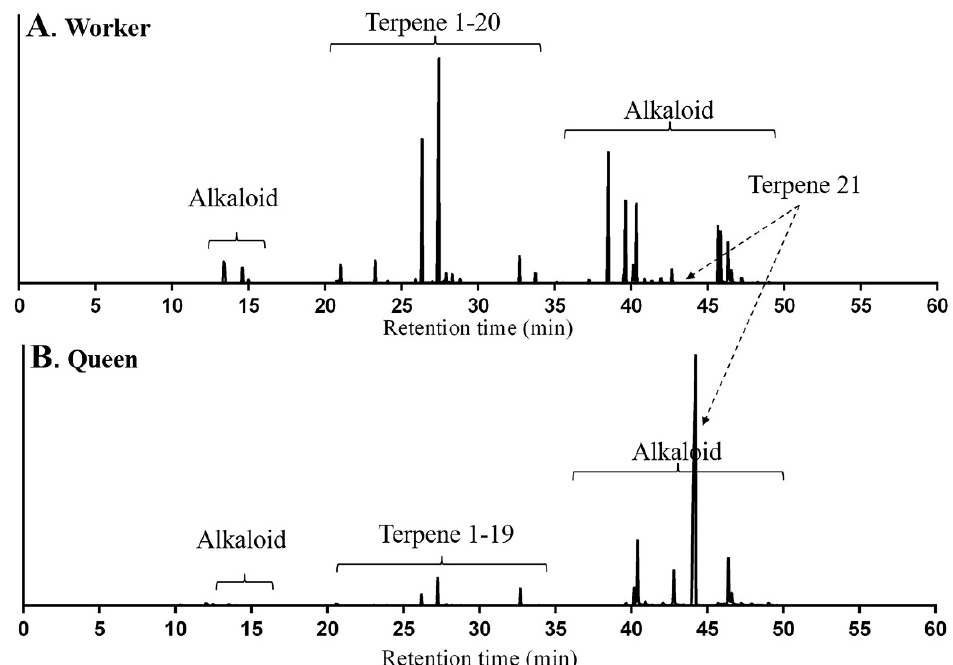
Figure 1. Total ion chromatogram of volatile compounds from Monomorium chinense workers ( A ) and queens ( B ) using solid-phase microextraction-gas chromatography-mass spectrometry (SPME-GC-MS) analysis with a DB-5 capillary column.